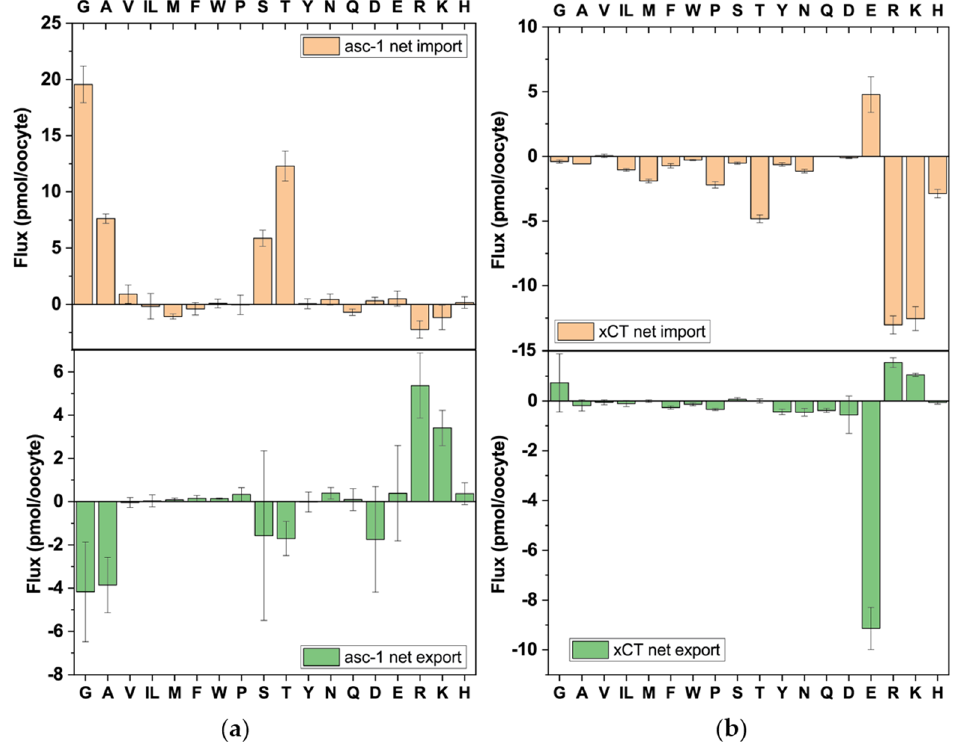
Figure 6. Analysis of antiport via asc-1 and xCT. Oocytes expressing 4F2hc–asc-1 ( a ) or 4F2hc–xCT ( b ) were incubated with labelled and unlabelled amino acids as described in Figure 2a. Net import (positive numbers) and net export (negative numbers) are shown. Isoleucine and leucine cannot be separated by LC–MS and are shown as IL.